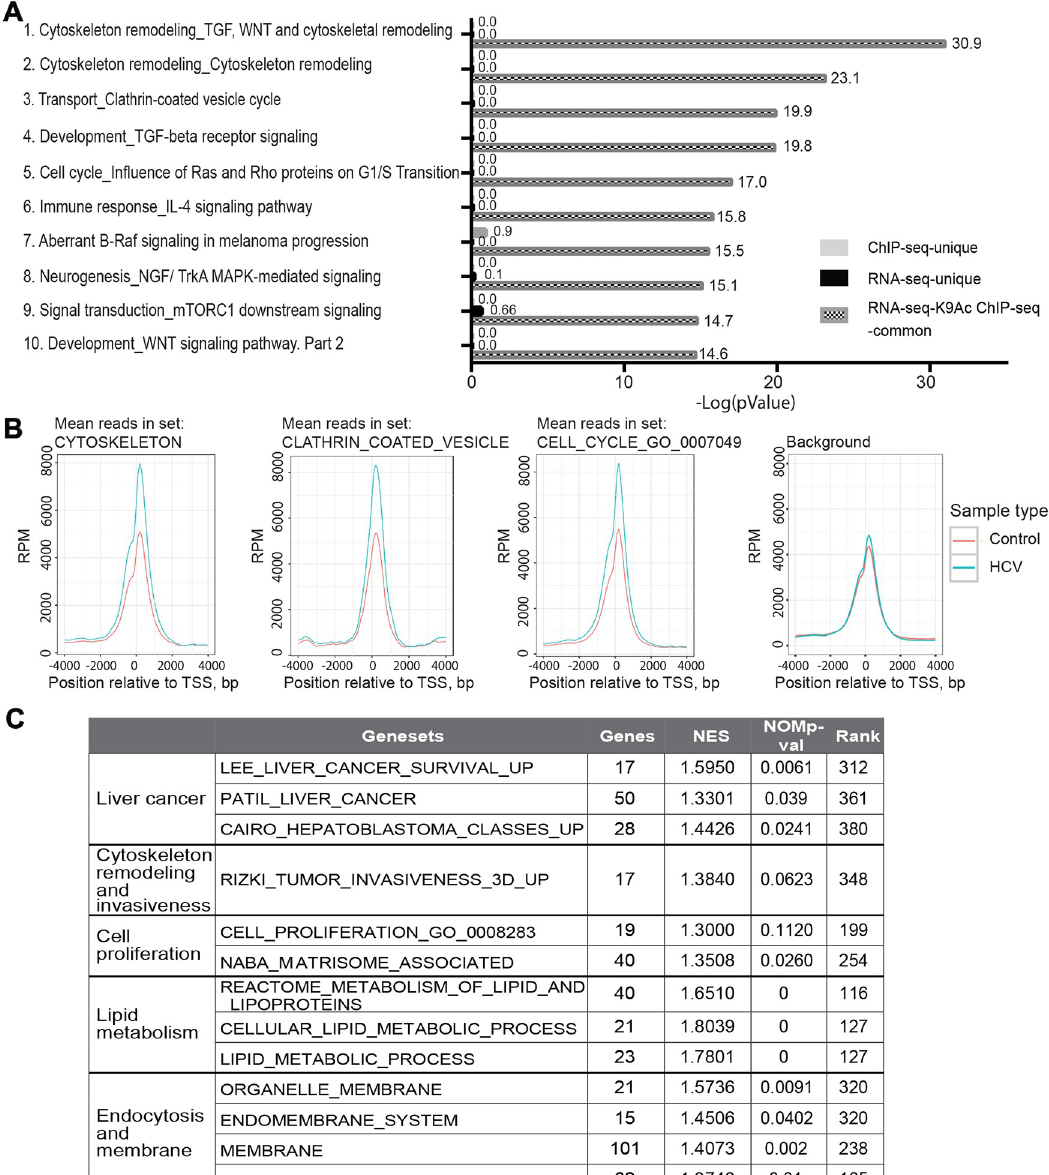
Fig 3. Pathway analysis generated from RNA-seq and H3K9Ac ChIP-seq integration data. (A) Pathway analysis was generated by using both the RNA-seq and H3K9Ac ChIP-seq data. Enrichment analysis consisted of matching gene IDs of possible targets for the "common”(common to the RNA-seq and H3K9Ac ChIP-seq data) and "unique" (unique to the RNA-seq or H3K9Ac ChIP-seq data) sets, with gene IDs in functional ontologies in MetaCore. The probability of a random intersection between a set of IDs the size of the target list with ontology entities is estimated by the p-value of the hypergeometric intersection. Data were generated using the Thompson Reuter MetaCore analysis GeneGo. The most significant pathway maps that are common to both the RNA-seq and H3K9Ac ChIP-seq data are shown. The Log10 of the p-value is presented. (B) Profiles of the combined H3K9Ac Chip-seq data across the TSS regions of genes belonging to the indicated GO gene sets, and a control background generated by ranking all genes by read depth and randomly selecting control genes within 20 rank positions of each gene in the primary gene sets. Each line represents a triplicate. RPM, reads per million. (C) GSEA generated from H3K9Ac ChIP-seq data. A ranked gene list was generated for the differential H3K9Ac ChIP-seq data according to the p value. This ranked list was used for Gene Set Enrichment Analysis (http:// software.broadinstitute.org/gsea/index.jsp).